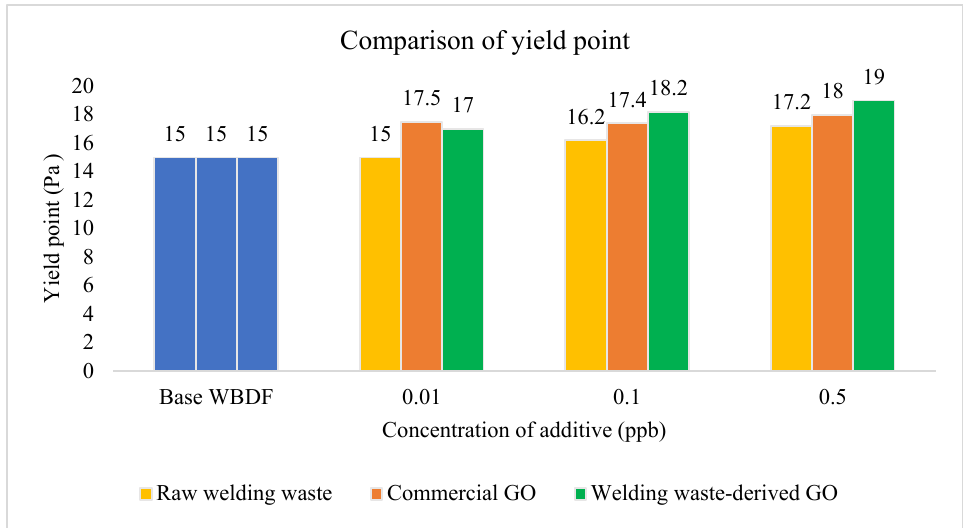
Figure 7. YP comparison of WBDF using different additives.